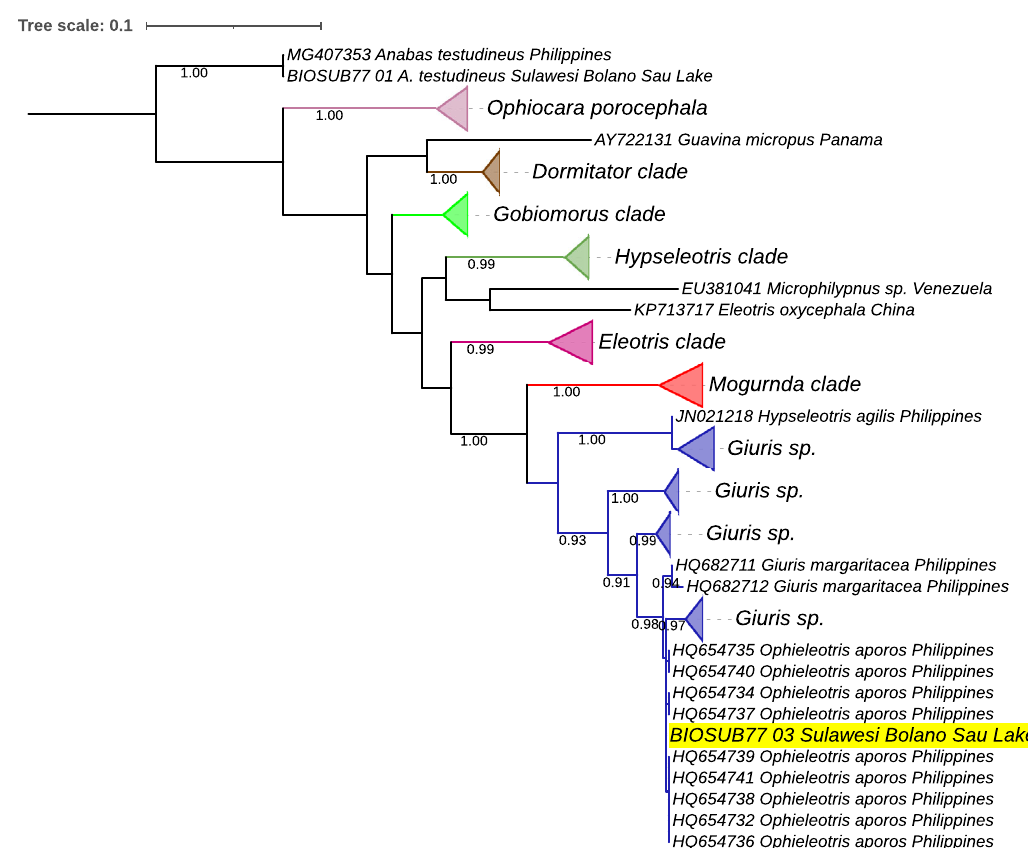
Figure 3. Evolutionary relationships of payangka from Bolano Sau Lake with several gobioid taxa and Anabas testudineus as an outgroup. The Bolano Sau Lake payangka sequence is highlighted in yellow. Evolutionary relationships were estimated using the Maximum Likelihood routine in MEGA X. 62 The analysis comprised 96 sequences with 630 nucleotide positions and 100 bootstrap replicates. The blue clade comprises sequences deposited in GenBank or BOLD databases as Giuris margaritacea and synonyms including Ophieleotris aporos. The length of the triangles is proportional to the number of sequences. The branch scale is in number of substitutions per